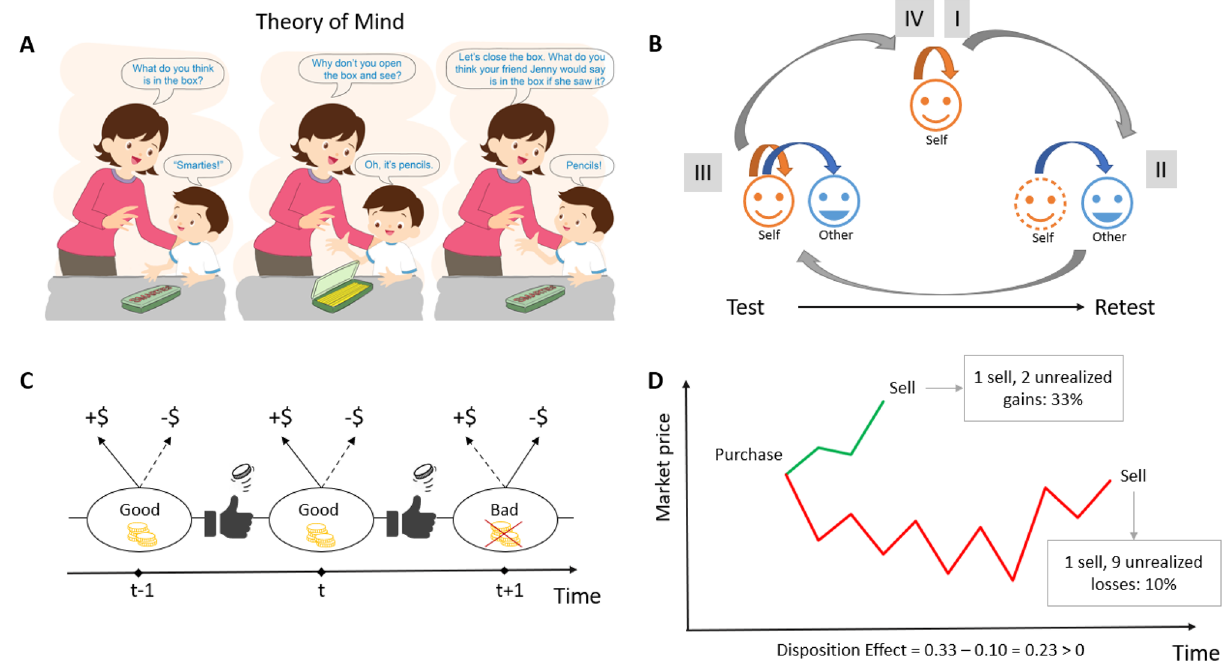
Figure 1. ( A ) ToM is the ability to abstract from one’s own experience to correctly guess the mindset of another. Here, the child incorrectly abstracts from its knowledge that the box contains pencils rather than smarties when predicting Jenny’s response 5 . Hence, the child has incorrect ToM. ( B ) Structure of one sitting in the experiment: (I) and (IV) Participant plays an investment game for self; (II) Participant plays the game for someone other, who never remains invested more than one round; (III) Participant makes choices for self and for other. ( C ) Stock price changes are more likely to be positive in the good regime; conversely, stock price changes are more likely to be negative in the bad regime; regime switches are random across rounds, determined by a biased coin flip. Under the Bayes-optimal strategy, gains rarely are realized, while losses are realized regularly. ( D ) Computation of the DE (Disposition Effect) metric: under the green price history between Purchase and Sale, gains were not realized for 2 rounds; under the red price history between Purchase and Sale, losses were not realized 9 rounds. The metric equals the difference between the percentage of periods with realized gains relative to all periods with gains (paper gains or realized gains) and the percentage of periods with realized losses relative to all periods with losses. In the example here, the player hangs on to losses much longer, and hence, DE is